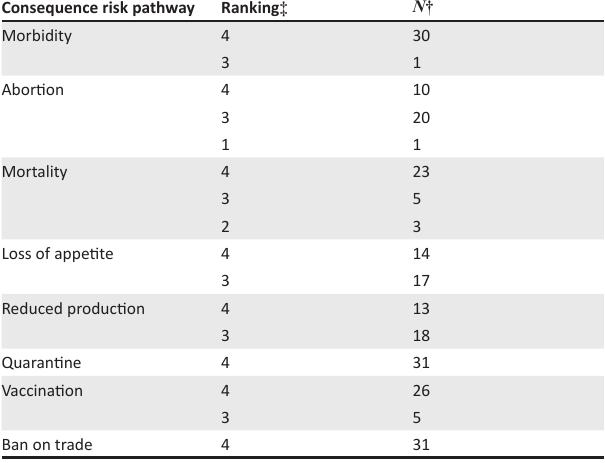
TABLE 4: Summarised results for qualitative ranking of Rift Valley fever outbreak consequences in cattle as perceived by the pastoralists’ key informants in Ijara,